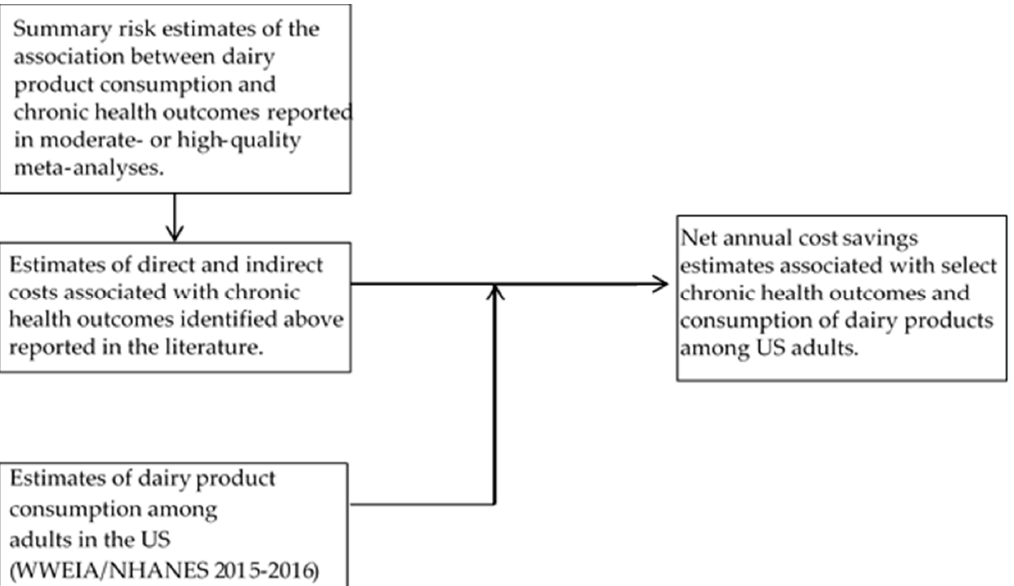
Figure 1. Overview of data inputs and model to estimate net annual cost savings associated with increased dairy consumption among adults in the United States (US). WWEIA = What We Eat in America; NHANES = National Health and Nutrition Examination Survey